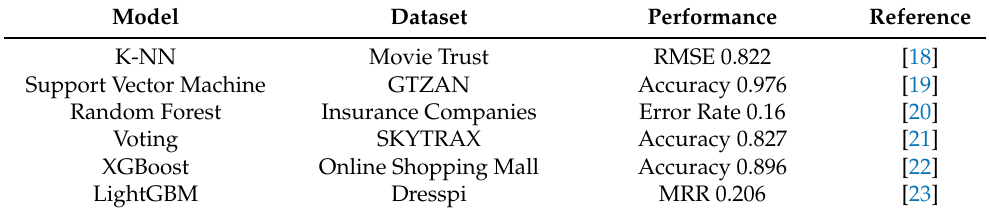
Table 1. AI-based recommendation